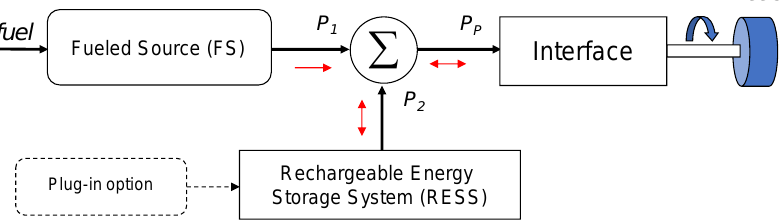
Figure 4. General architecture of a hybrid vehicle.